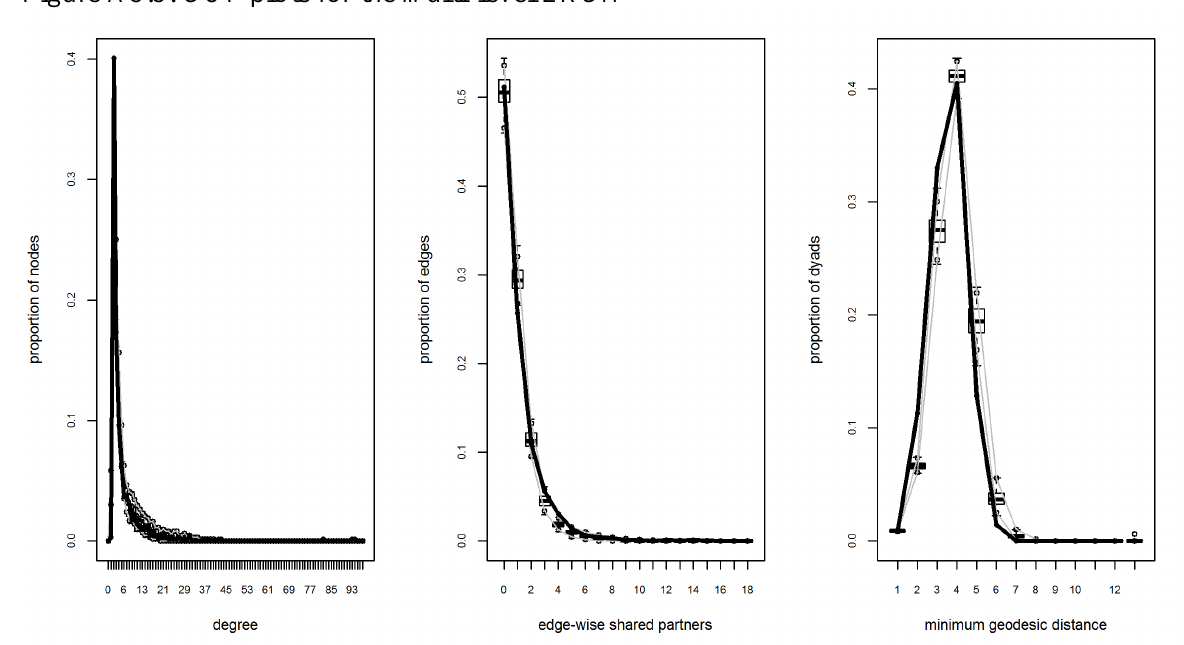
Figure A3.3: GOF plots for the multi-level